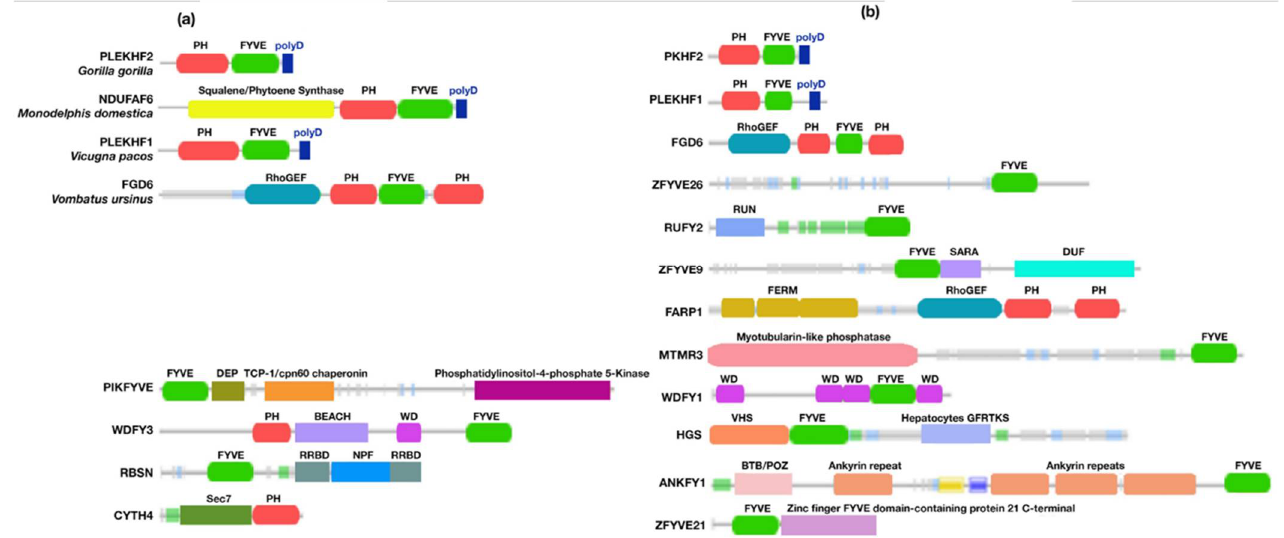
Figure 5. Schematic representation of PH-, FYVE-, and polyD-containing modules found in proteins from nonhuman mammals ( a ) and humans ( b ). Other unique domains are also shown. Table 2. Different modules found in mammalian Phafin2 and PH-, FYVE-, and polyD-containing proteins.